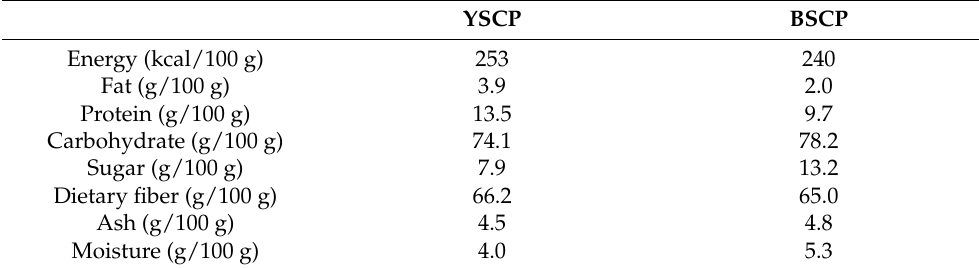
Table 1. Nutrients of yellow and black soybean seed coat powder.